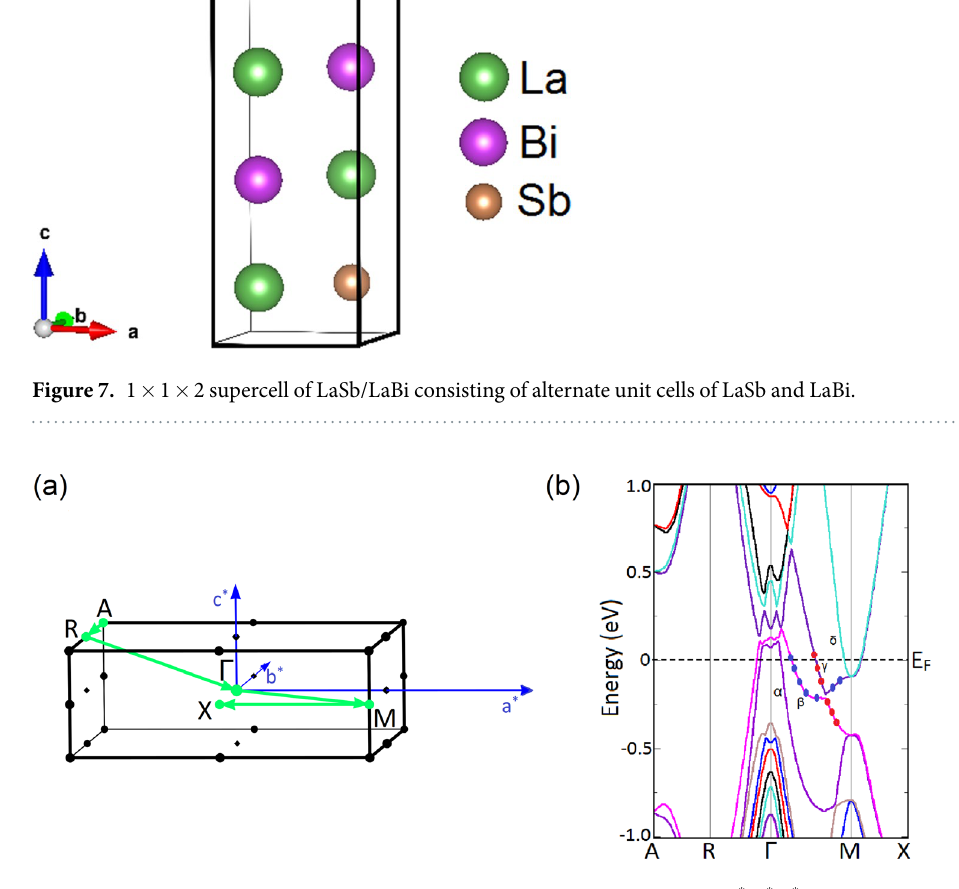
Figure 8. ( a ) The bulk Brillouin zone of the LaSb/LaBi heterostructure. Here, a * , b * , c * denote the reciprocal lattice vectors. ( b ) Bulk band structure along the high symmetry directions ( − − Γ − − A R M X ) calculated using mBJLDA functional when the SOC axis is parallel to the (001) direction. The contribution of La-d orbitals are shown by red dots and the contribution of the Bi/Sb-p orbitals are denoted by blue dots. β and γ band get inverted near the X -point as indicated by the switching of the orbital characters along the Γ − M